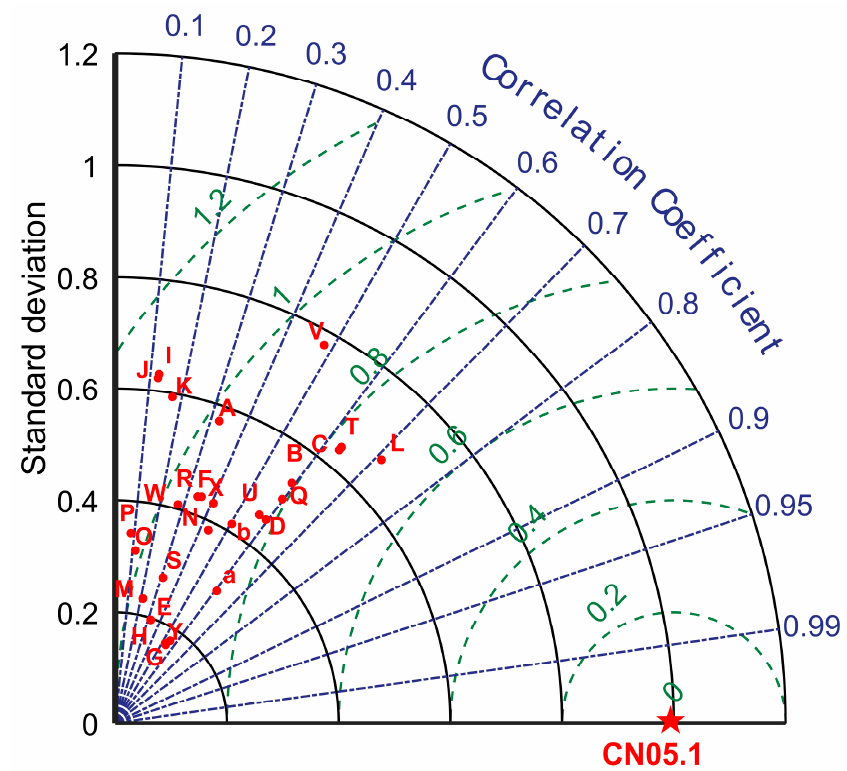
Figure 2. Taylor chart of CMIP6 models in simulating wind speed in the ARNC during